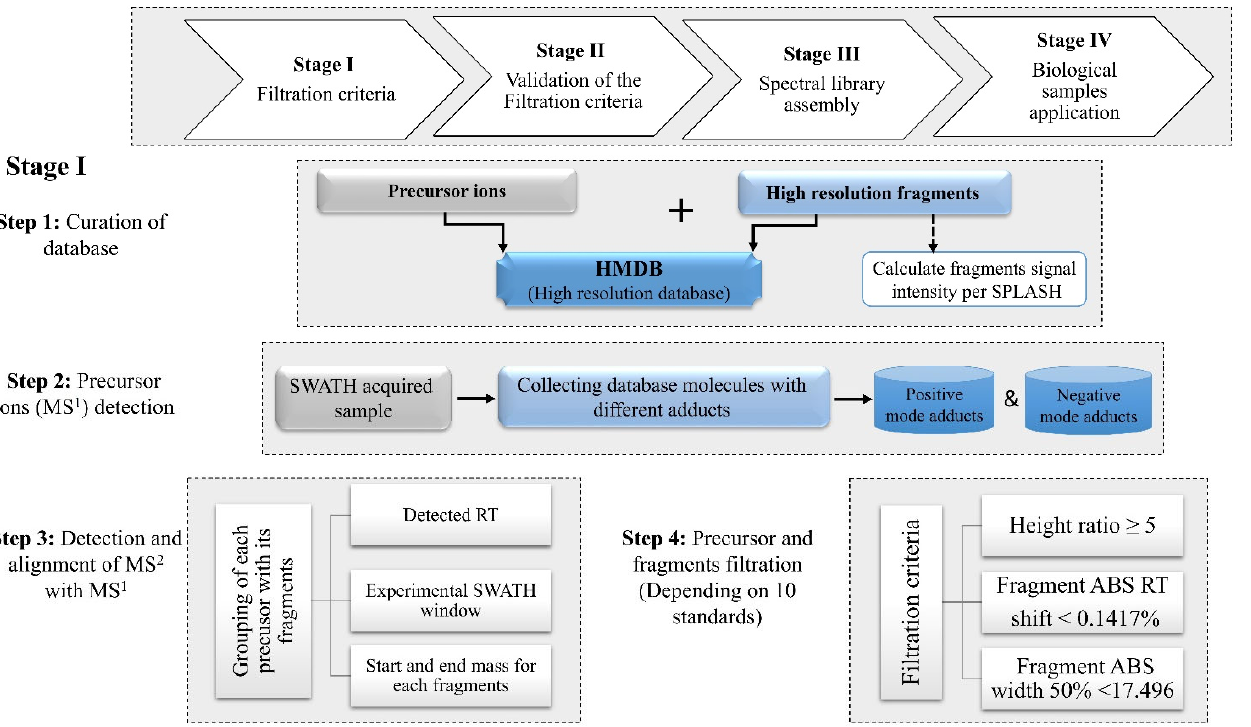
Figure 1. Experimental design and schematic illustration of the SWATH ‐ Auto System Analyzer (SASA) workflow for small molecule extraction of SWATH ‐ acquired samples. The pipeline of the filtration criteria ( Stage I ) includes four steps: ( Step 1 ) curation of database (MS1, MS2, and the relative intensity); ( Step 2 ) precursor ions (MS1) detection; ( Step 3 ) detection and alignment of MS2 with MS1; ( Step 4 ) precursor and fragments